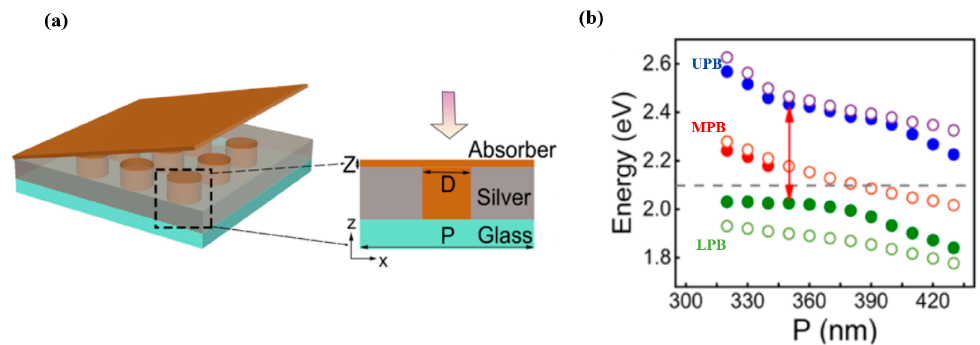
Figure 12. ( a ) Schematic diagram of the multiple plasmonic modes and a single molecular exciton hybrid system. ( b ) Dispersive curves of the hybrid polaritonic energies based on the coupled model in the period 320–430 nm. Adapted with permission from Ref. [135]. Copyright 2020 American Chemical Society.